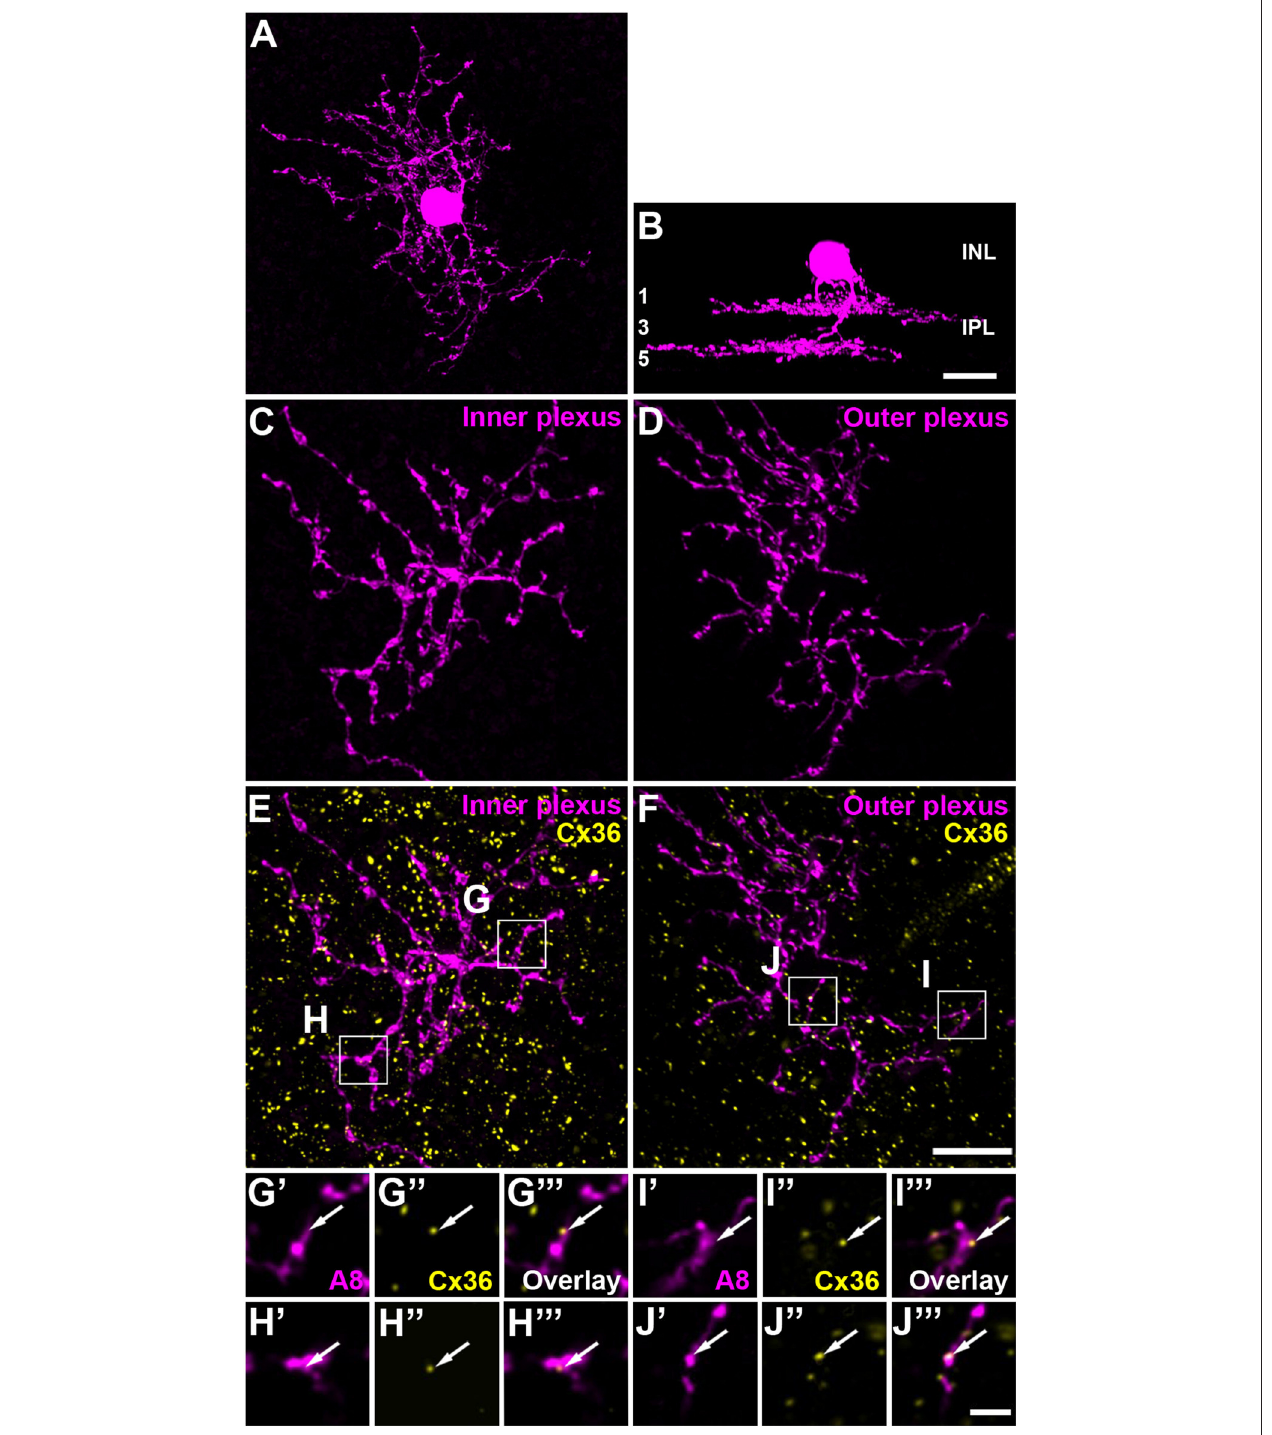
FIGURE 1 | A8 cell expressed connexin36 (Cx36) at their inner and outer plexus, in the ON and OFF sublamina of the inner plexiform layer (IPL), respectively. (A) Maximum projection of an Alexa-568-injected A8 cell. (B) Same cell as in (A) , XZ-rotation of a confocal stack shows the typical bistratified morphology of the A8 cell. (C,D) Maximum projection of inner (C) and outer dendrites (D) of the injected A8 cell. (E,F) Maximum projection of the overlay of Cx36 with inner (E) and outer dendrites (F) of A8 cell. (G’–J”’) Selected areas from (E,F) as single, magnified sections: A8 dendrites (G’,H’,I’,J’) , Cx36 (G”,H”,I”,J”) , and the respective overlays (G”’,H”’,I”’,J”’) . Arrows denote colocalization of Cx36 with A8 cell dendrites. Scale bar: (A–F) , 10 µ m; (G’–J”’) , 2 µ m.